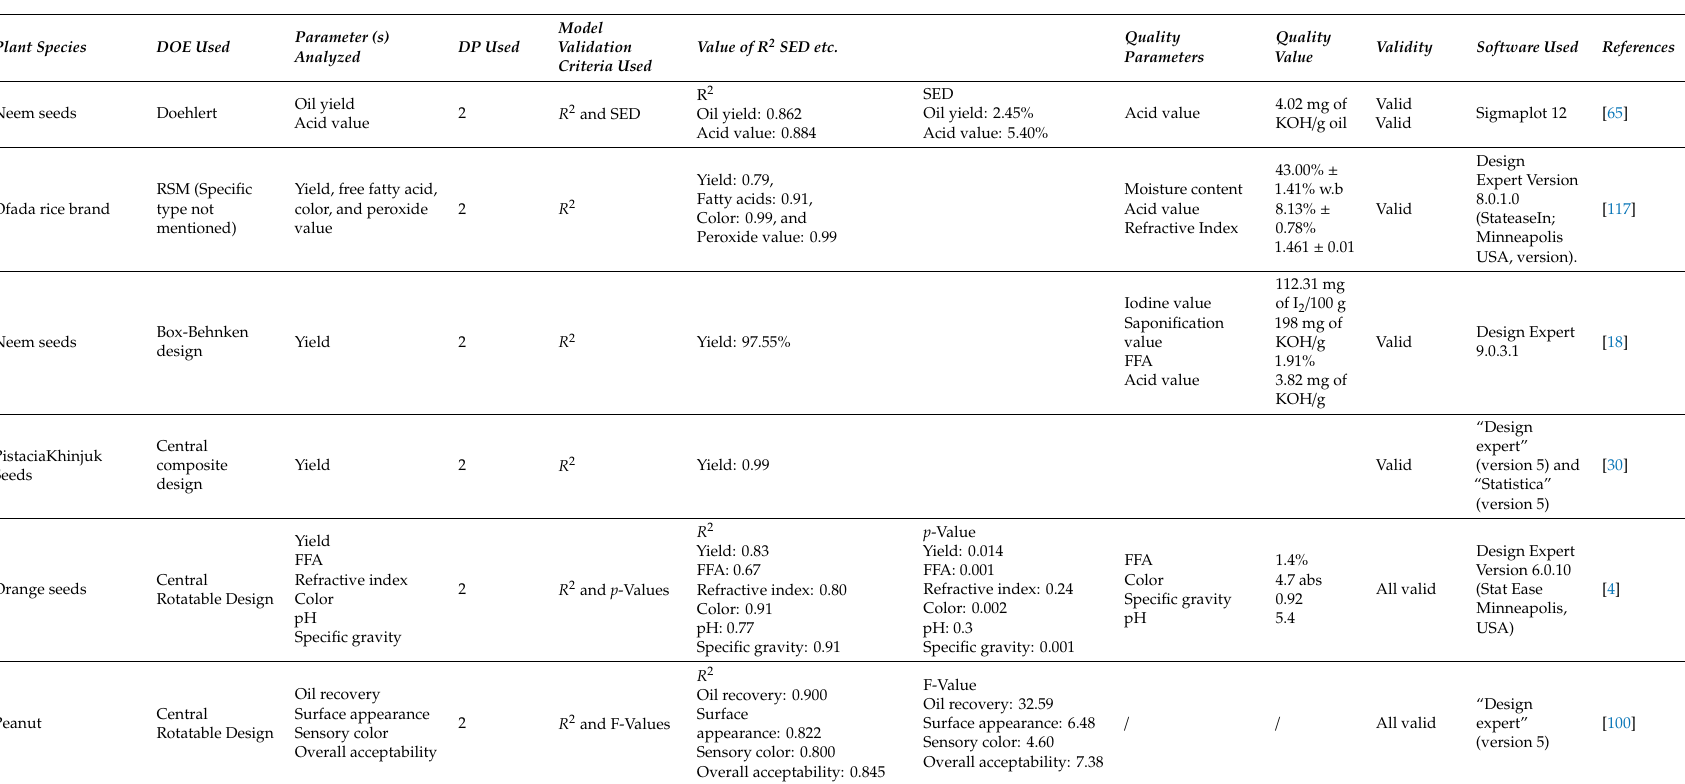
Table 2. Summary of model validation parameters and type of modelling software